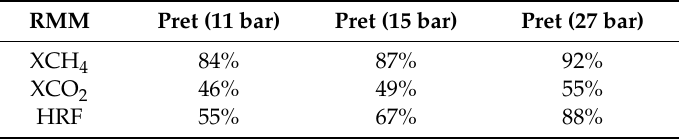
Table 8. E ff ect of pressure on retentate side in